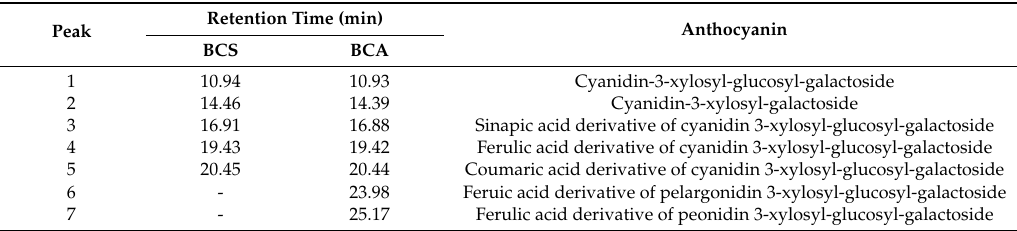
Table 1. Retention time and anthocyanin identification from black carrot extracts BCS (extracted with ethanol/citric acid) and BCA (extracted with ethanol/acetic acid).